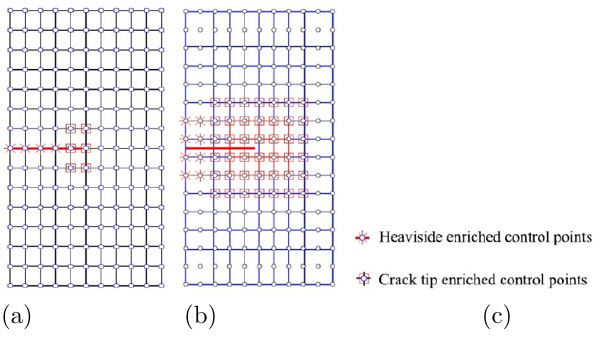
Figure 2. Crack geometry and enriched control points, (a) basis functions of order 1, (b) basis functions of order 3, (c) Heaviside enriched control points and crack tip enriched control